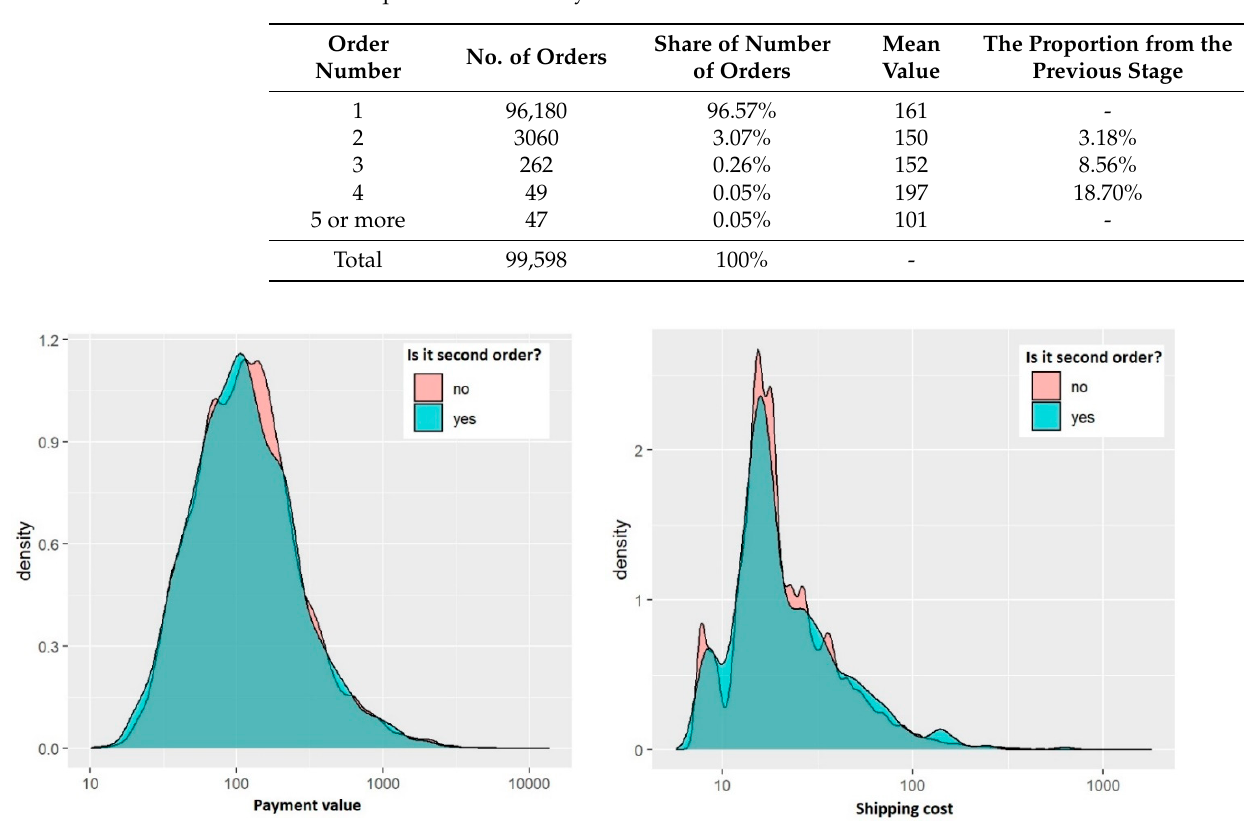
Figure 4. Density distributions of payment value and transportation cost in groups of first and second purchase. Note: x-axis is log-transformed.